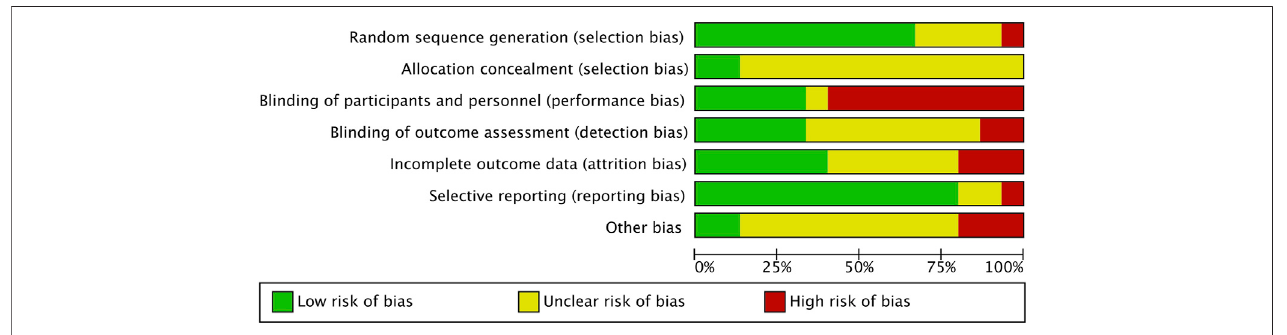
FIGURE 2 | The summary of risk of bias.